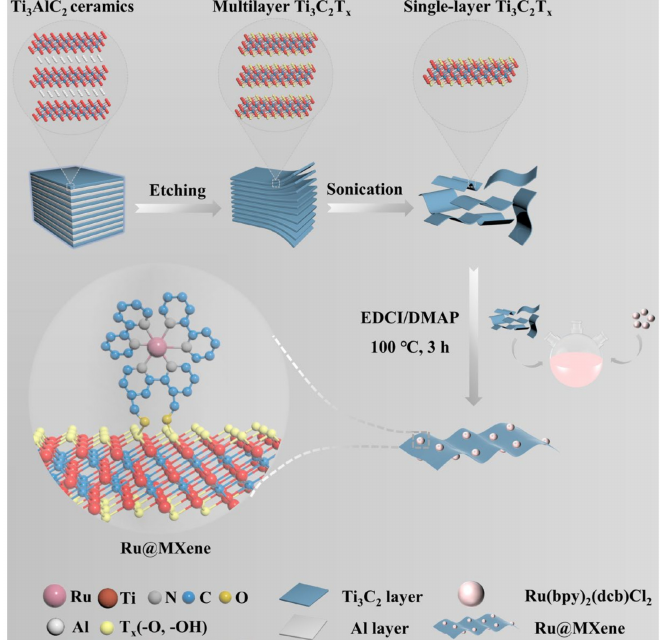
Figure 1. Schematic illustration of the preparation of Ru@MXene nanocomposites.